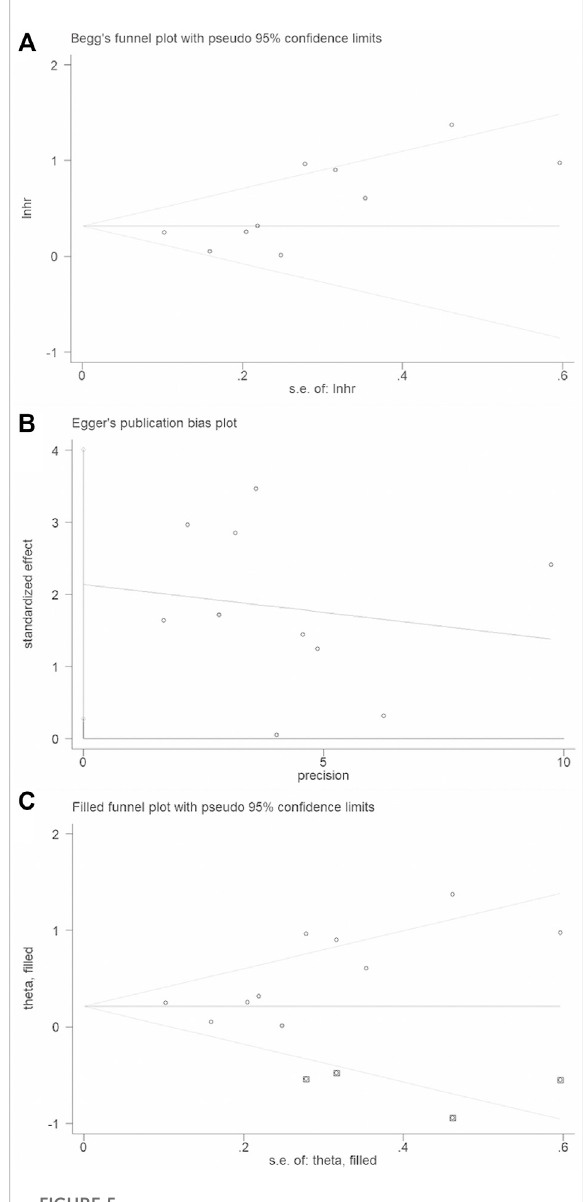
FIGURE 5 Publication bias and trim and fi ll analysis of the enrolled analysis: (A) . The Begg ’ s funnel plot; (B) . The Egger ’ s test. (C) . Trim and fi ll